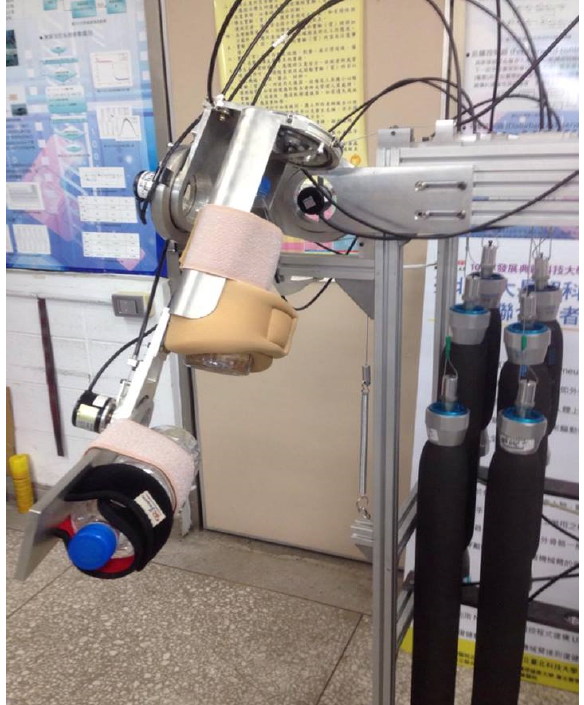
Figure 22. Schematic diagram of the robotic arm in the loading experiment.